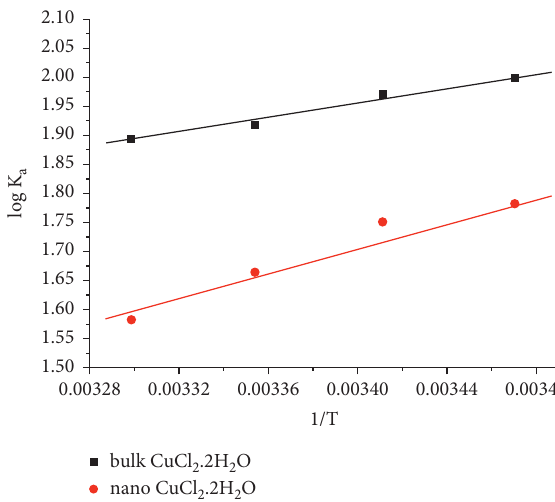
Figure 8: Variation of log K − 1 ) of for bulk and nano-CuCl a with l/ T (K 2 .2H 2 O in distillate H 2 O at 288.15, 293.15, 298.15, and 303.15K. Table 6: Gibbs free energy of association ( Δ G A ), enthalpy change ( Δ H A ), and entropy change ( Δ S A ) for bulk and nano-CuCl 2 distillate H 2 O at different